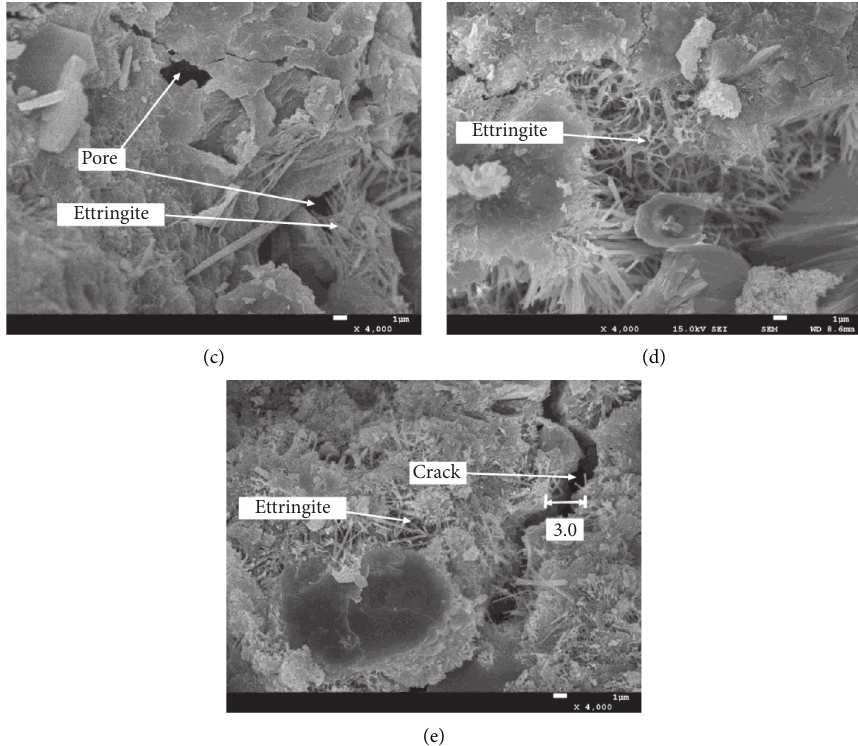
Figure 7: Microstructure of the concrete in the MFT environment. (a) 0 freeze-thaw cycles; (b) 25 freeze-thaw cycles; (c) 50 freeze-thaw cycles; (d) 75 freeze-thaw cycles; and (e) 100 freeze-thaw cycles.